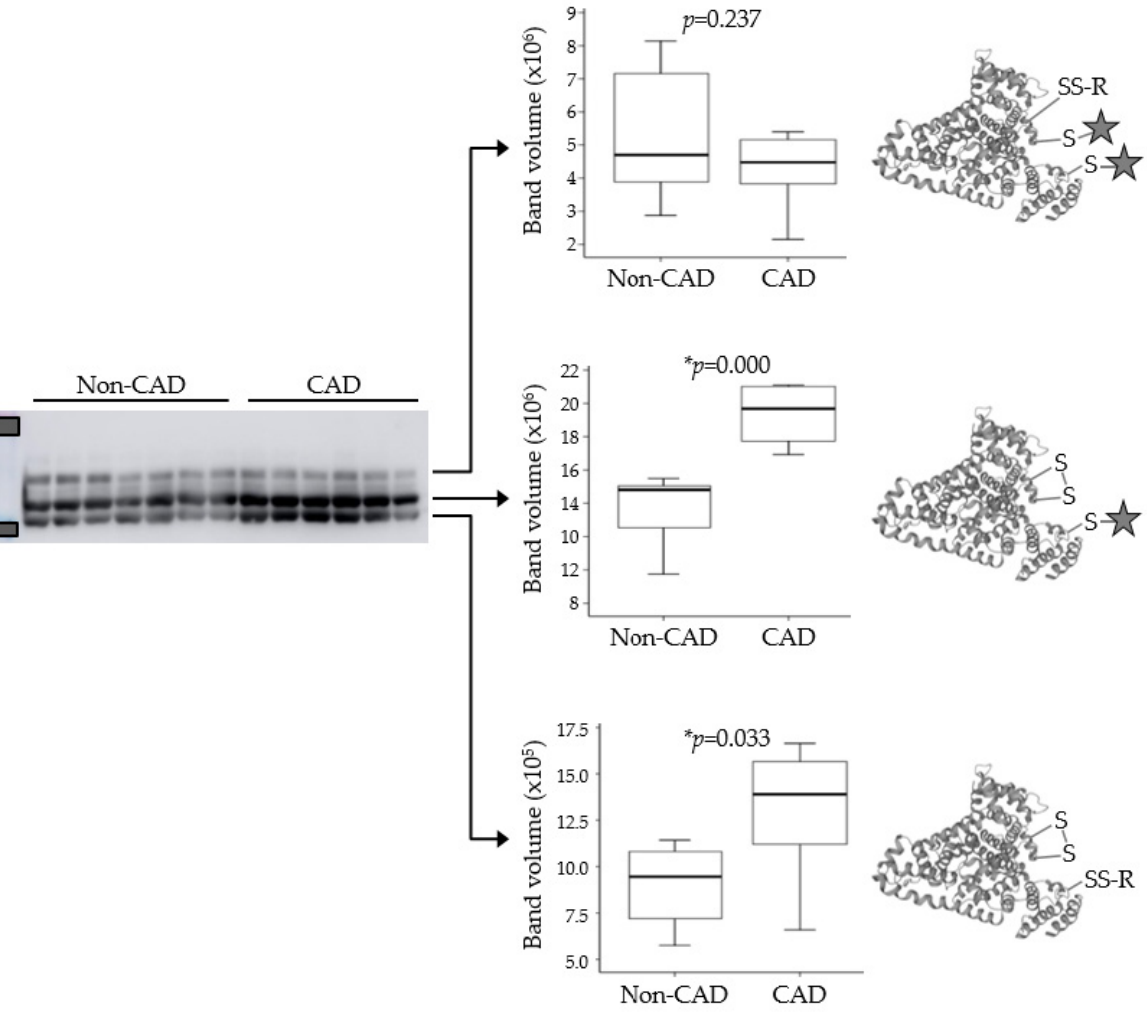
Figure 4. The thiol state of human serum albumin in patients with calcific aortic valve disease, with and without coronary artery disease (CAD). Western blot using ‐ SulfoBiotics ‐ labeling (star) showed that albumin with 1 and 2 oxCys were more abundant in patients with CAD. We did not find significant differences in the most reduced form of this protein.